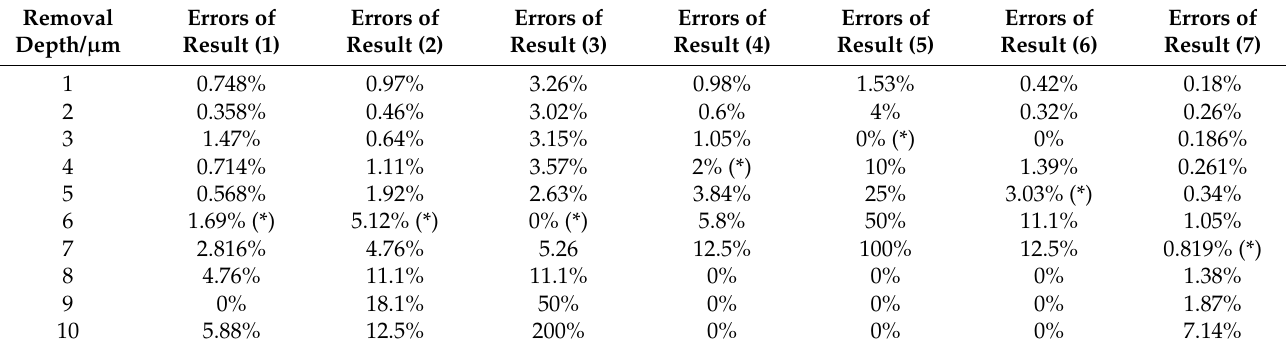
Figure 10. Predicted and actual number of damage points (<50 μm) under seven different sets of initial damage points. Table 5. The relative error between predicted results and the actual test results.